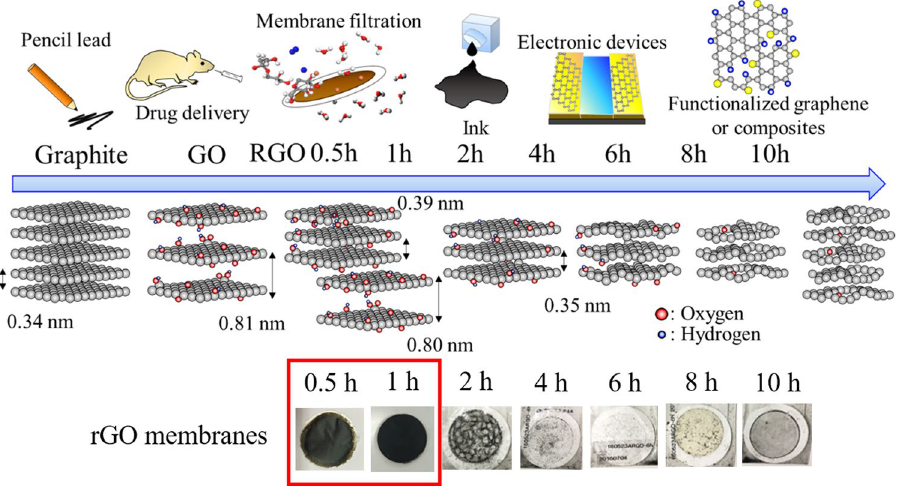
Figure 8. Schematic illustration of overall structural evolution of hydrothermally reduced GO and its potential applications. Lower part: the photographs of rGO membranes formed at different time